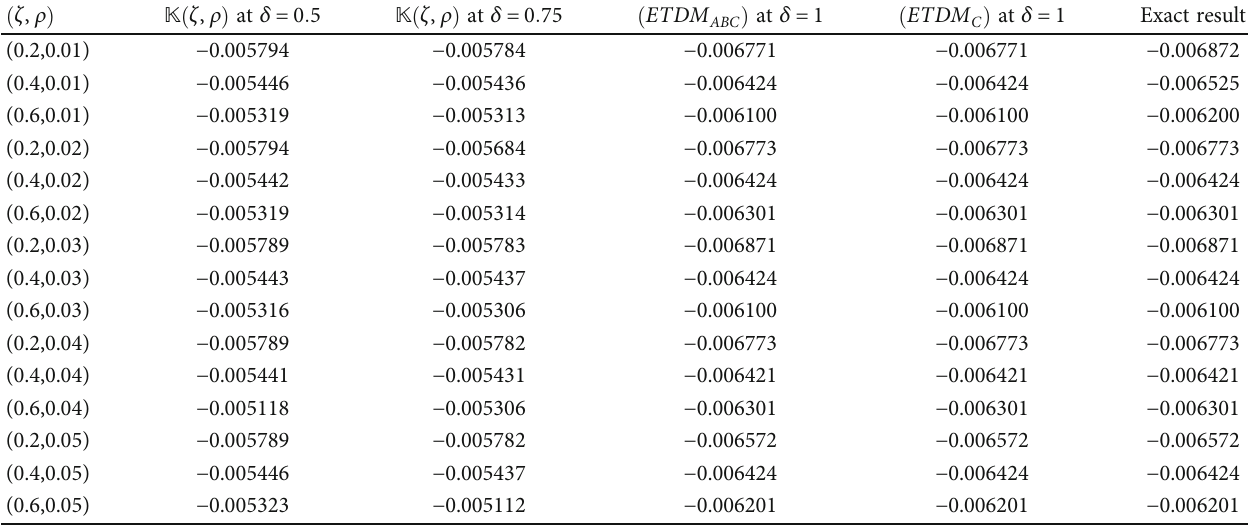
Table 4: Proposed method solution for K ð ζ , ρ Þ at di ff erent fractional orders of problem 2.